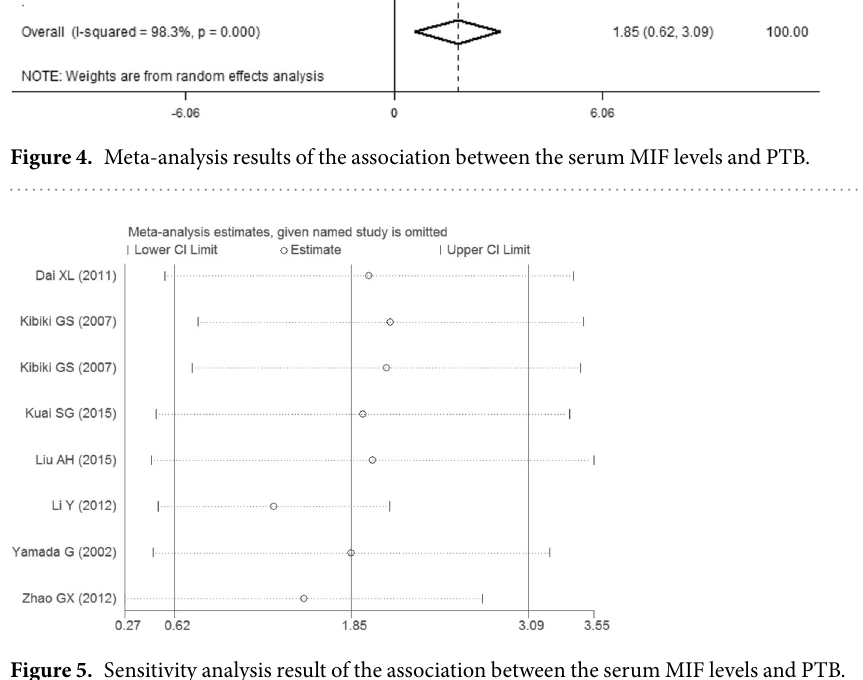
Figure 5. Sensitivity analysis result of the association between the serum MIF levels and